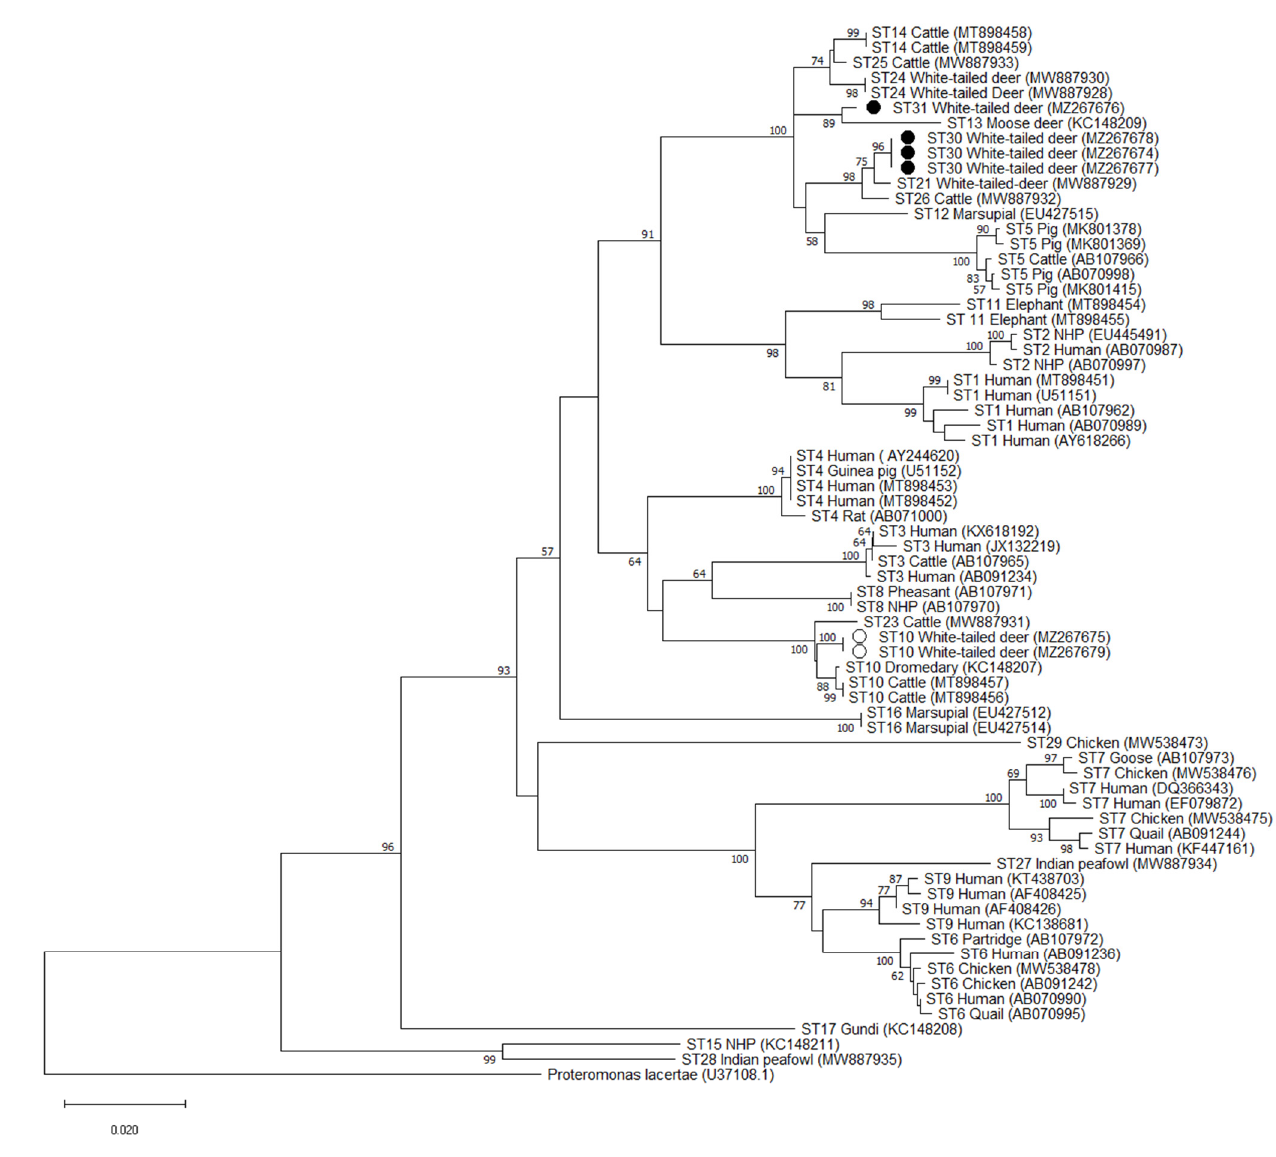
Figure 3. Phylogenetic relationships among Blastocystis barcoding region sequences generated in the present study (novel subtypes are represented with a black filled circle and other subtypes with an unfilled circle) and representative reference sequences of all accepted subtypes. Proteromonas lacertae was used as outgroup taxon to root the tree. Analysis was conducted by a neighbor-joining method. Genetic distances were calculated using the Kimura two-parameter model. This analysis involved 70 nucleotide sequences, and there were a total of 590 positions in the final dataset. Bootstrap values lower than 50% are not displayed.